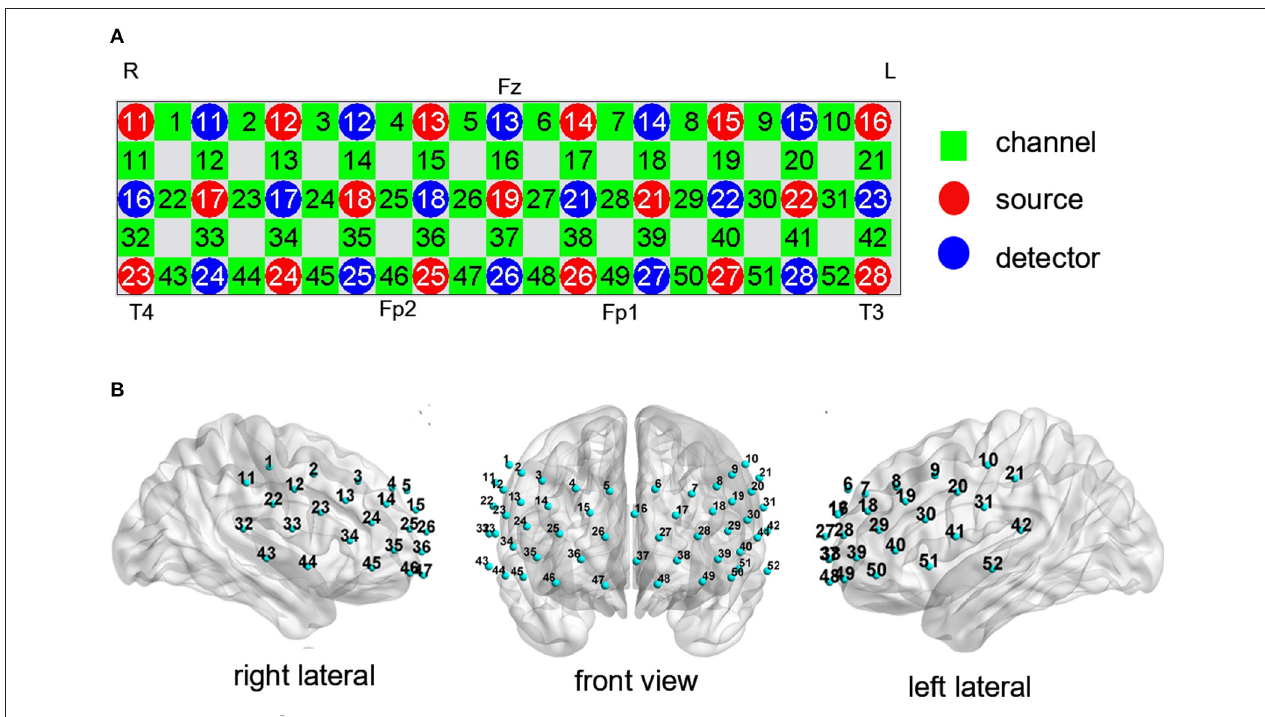
FIGURE 2 | Measurement points of the 52-channel near-infrared spectroscopy (NIRS) system. (A) The arrangement of channels was based on the international 10–20 system. (B) The 3-dimensional detection region for each channel.